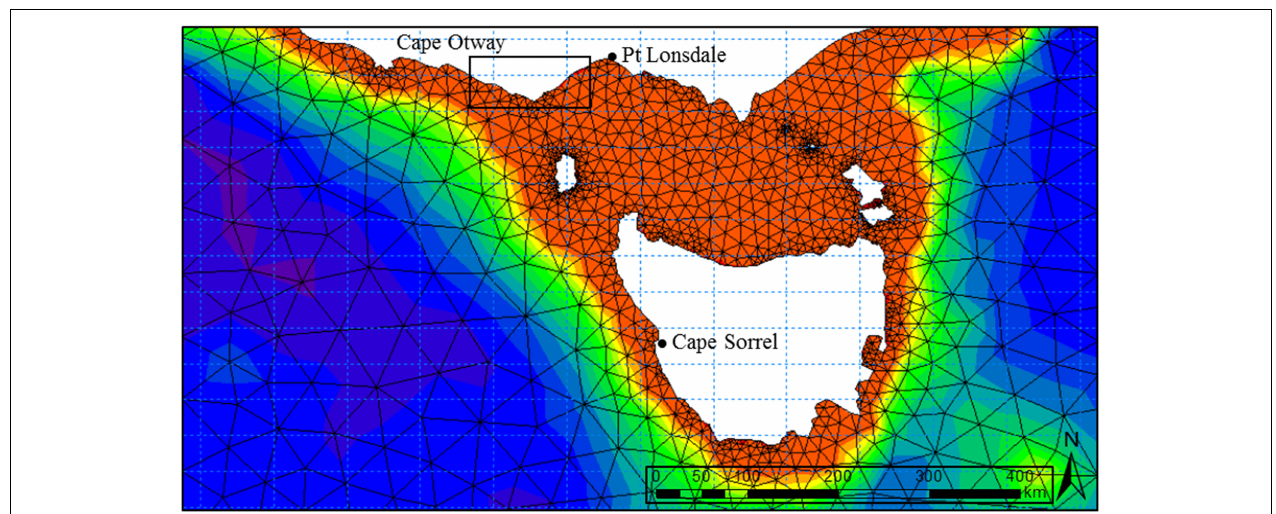
Boundary inputs were obtained from the NOAA Wavewatch III global hindcast model. Wave buoy locations used to calibrate the model are located